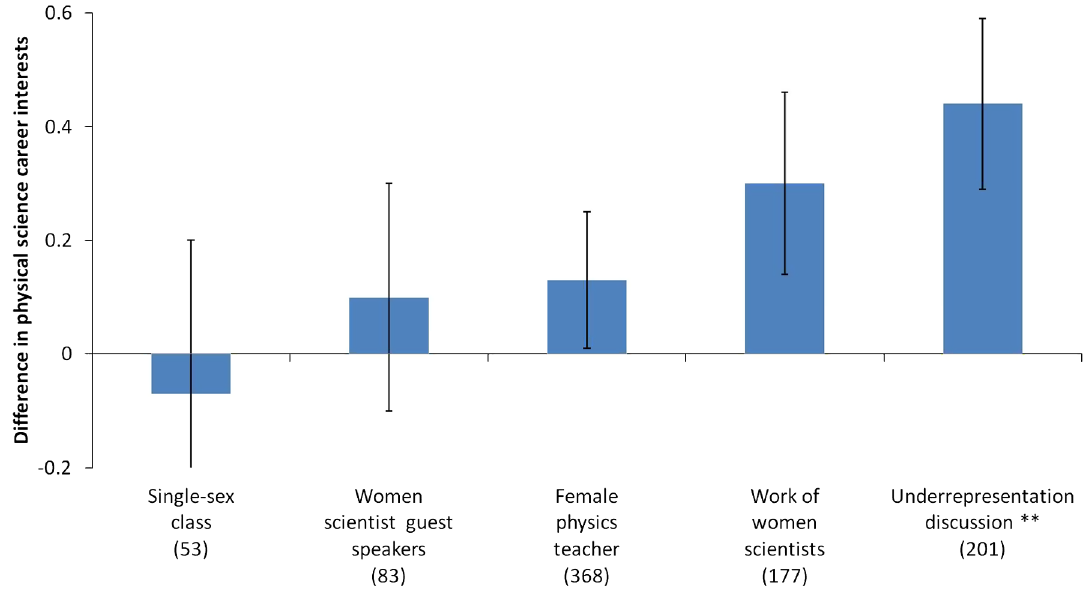
FIG. 1 (color online). Difference in treatment and control group means for physical science career interest (6-point scale) for five high school physics classroom conditions ( n for each group in parentheses). Error bars represent (cid:3) 1 standard error. ** denotes p < 0 : 01 .